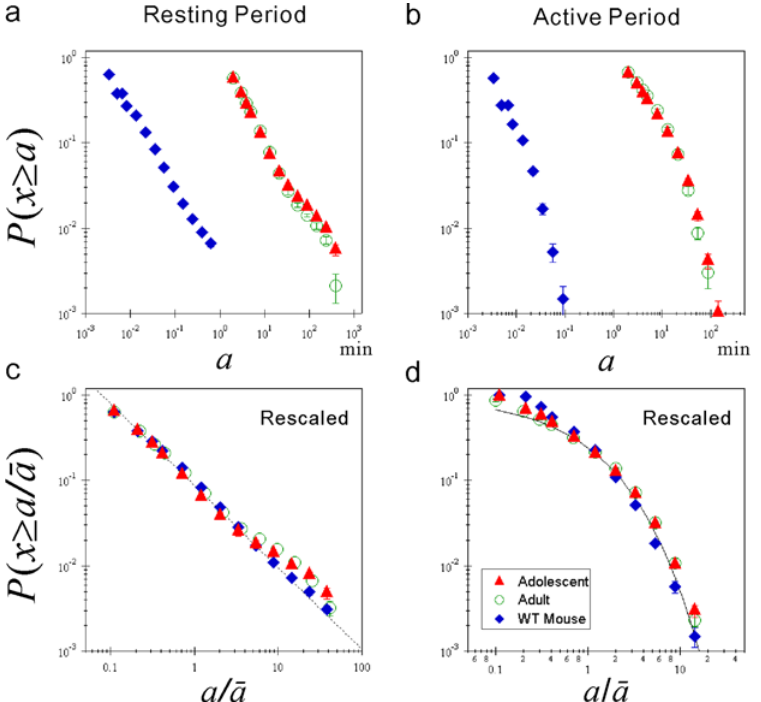
Figure 2. Universal distribution laws of behavioral organization. Cumulative distributions of resting and active period durations of locomotor activity in healthy humans and wild-type (WT) mice. ( a ) Cumulative distributions P ( x $ a ) of resting period durations a for human adolescents (closed triangles), adults (open circles) [3], and WT mice (filled diamonds). The error bars indicate the standard error of the mean. ( b ) The same as ( a ), but for active period durations. ( c ) Group averaged rescaled cumulative distributions of ( a ). The straight line is an eye-guide with the overall adult mean scaling exponents c ~ 0 : 96 as the slope. Note that the plots are shifted along the vertical axis to take the same value at a = a ~ 0 : 1 for the purpose of illustration. ( d ) The same as ( c ), but for active period durations. The solid curve is a stretched exponential function with the overall mean of values; a ~ 1 : 43 and b ~ 0 : 54 .